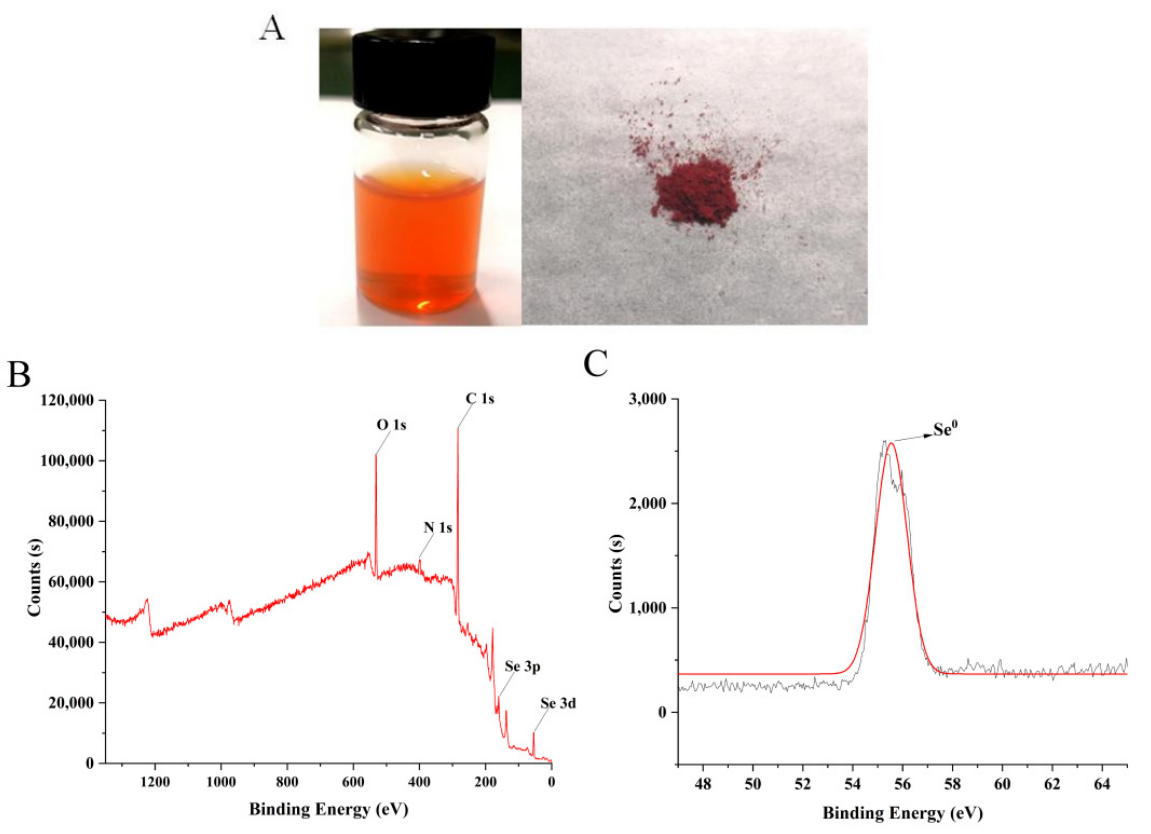
Figure 1. The solution and lyophilized powder of LCS-SeNPs ( A ); XPS spectrum of LCS-SeNPs ( B , C ).